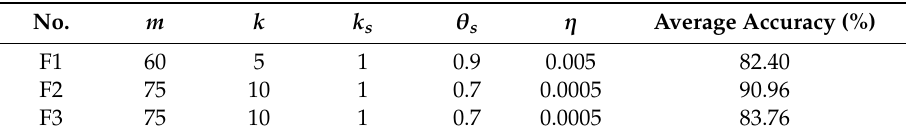
Table 10. Optimum parameters of the DNM + back-propagation (BP).